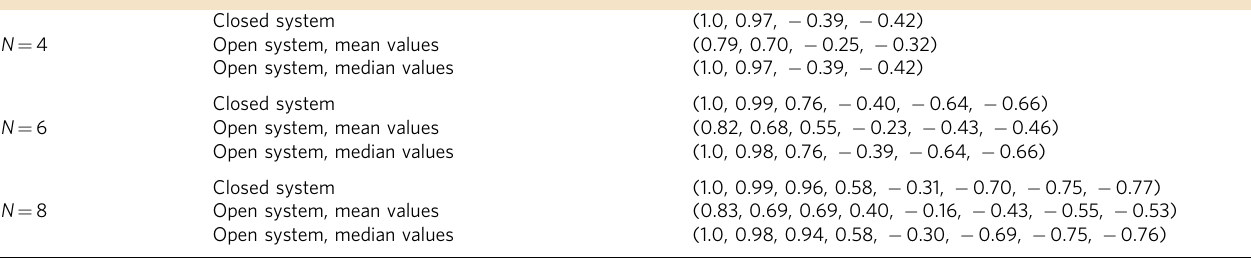
Table 1 | Annealing in effective spin model with and without noise. Closed system